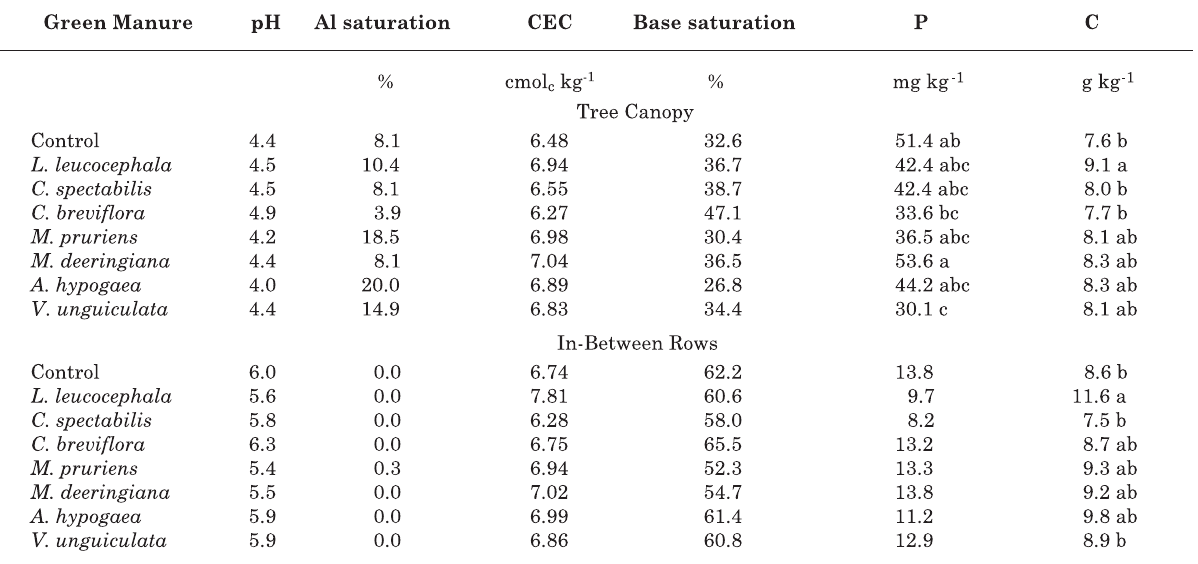
Table 1. Soil chemical properties (0–10 cm layer ) after10 years of summer green manures in-between coffee